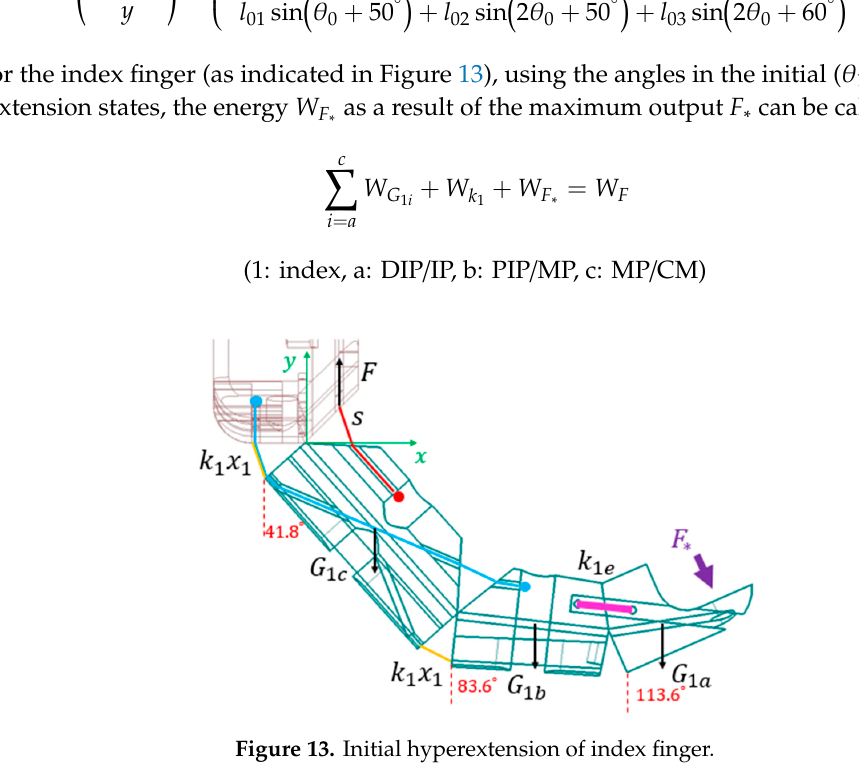
Figure 13. Initial hyperextension of index finger.